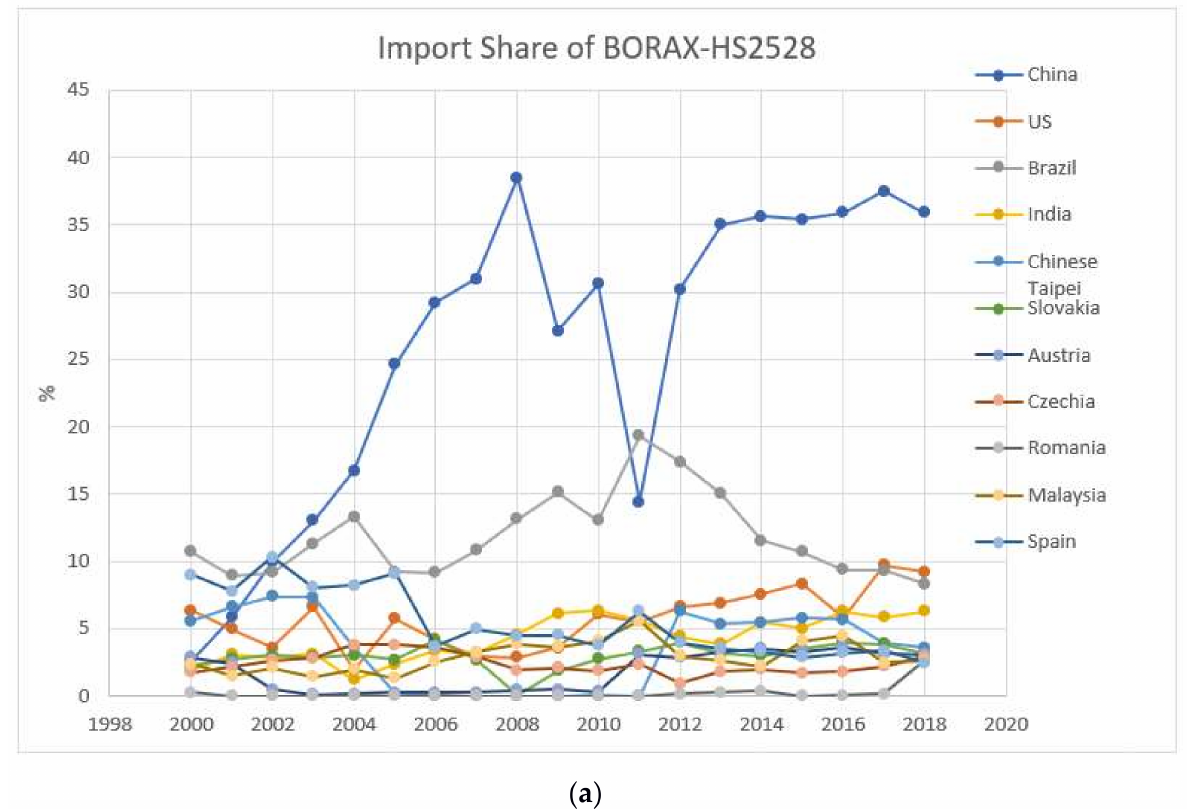
Figure 4. Boron products’ exportation. ( a) Export Share of BORAX-HS2528; ( b) Export Shares of BORATES-HS2840; ( c ) Export Share of BORON-HS2810.